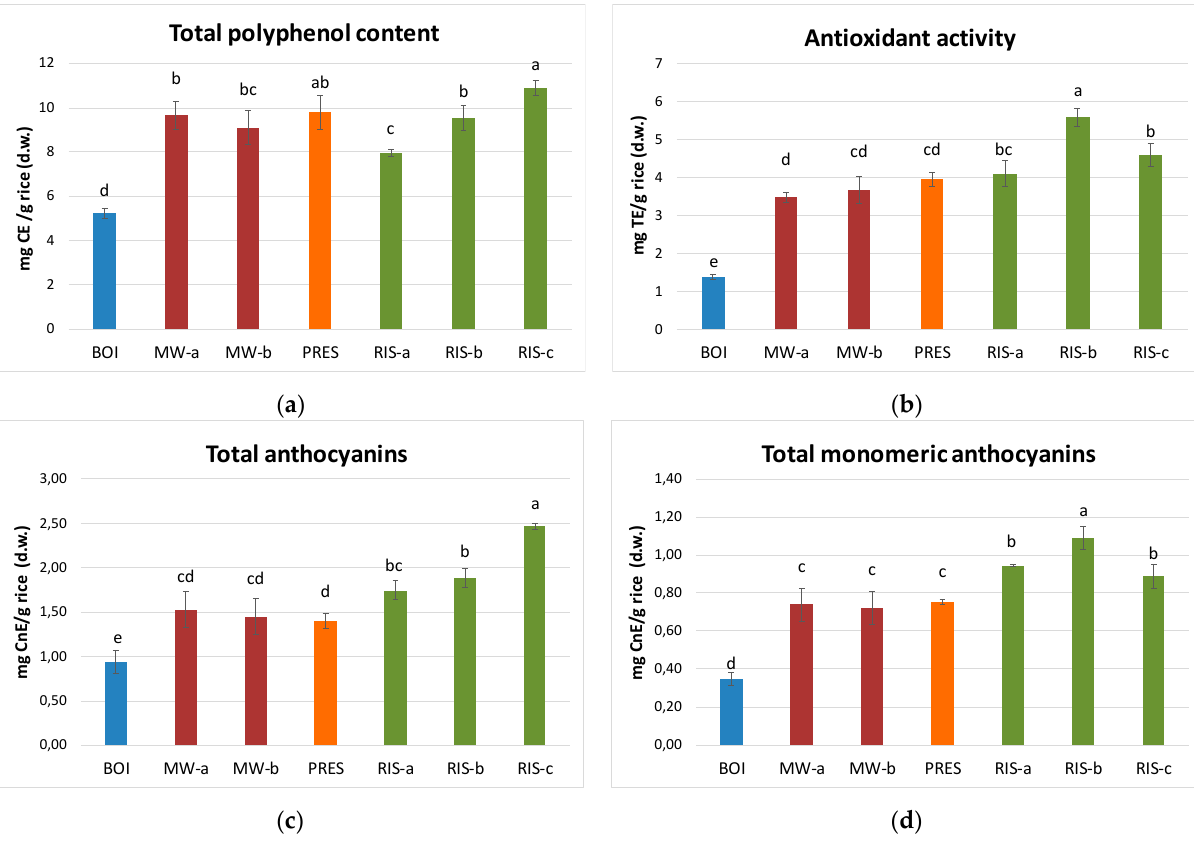
Figure 1. ( a )Total phenolic content (mg CE/g d.w.), ( b ) total antioxidant activity (mg TE/g d.w.), ( c ) total anthocyanins (mg CnE/g d.w.), and ( d ) total monomeric anthocyanins (mg CnE/g d.w.) quantified in cooked black rice, expressed as mean ± standard deviation. For each parameter, values with different letters are significantly different ( p < 0.05). CE: catechin equivalents; CnE: cyanidin-3-O-glucoside equivalents; TE: Trolox equivalents.